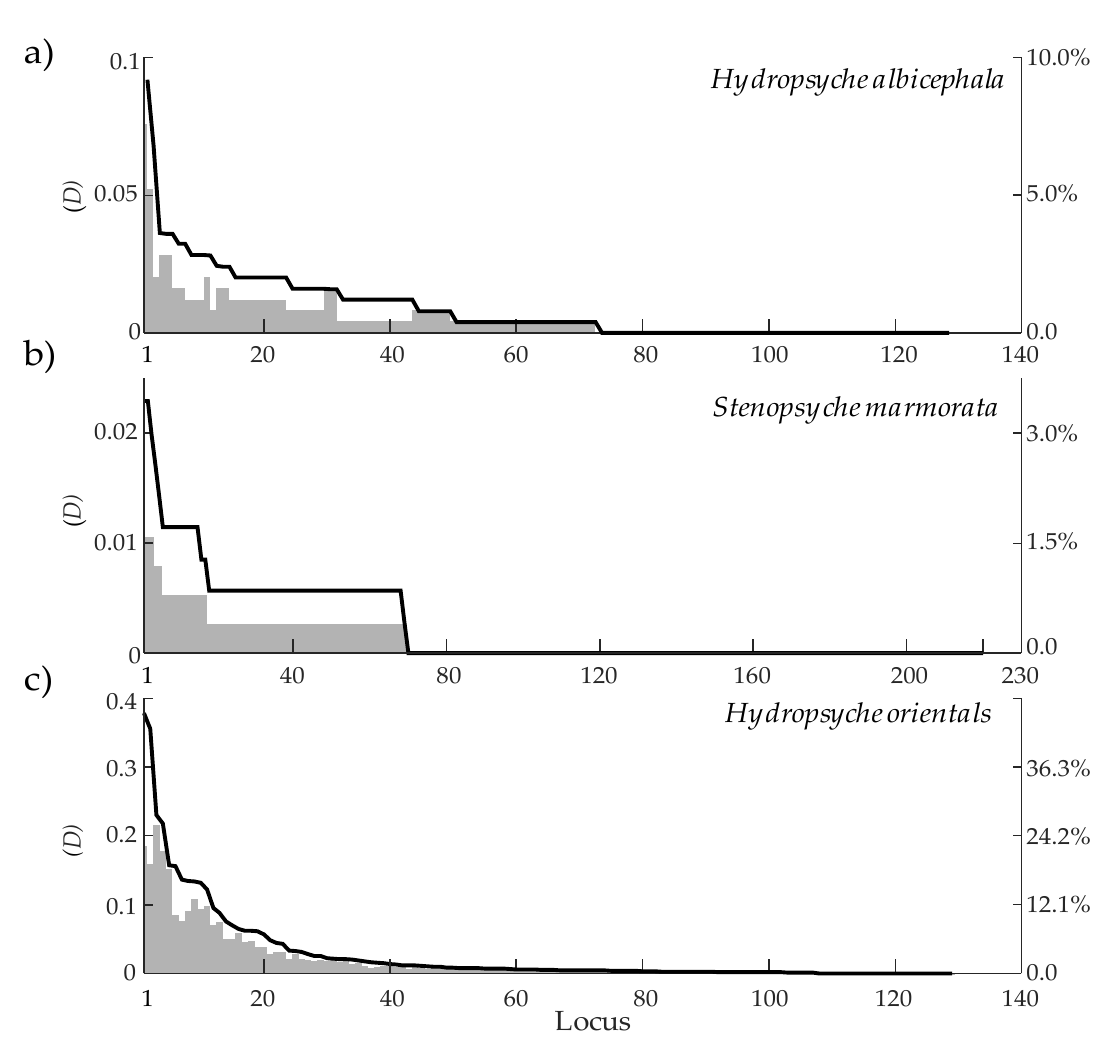
Figure 6. Cluster distance ( D : solid line matching the scale in the left side of y axis) and proportion of individuals (gray shade matching the scale in the right side of y axis) experiencing cluster change in relation to the order of D (x axis) after recognition in Hydropsyche albicephala ( a ); Stenopsyche marmorata ( b ); and Hydropsyche orientals ( c ).